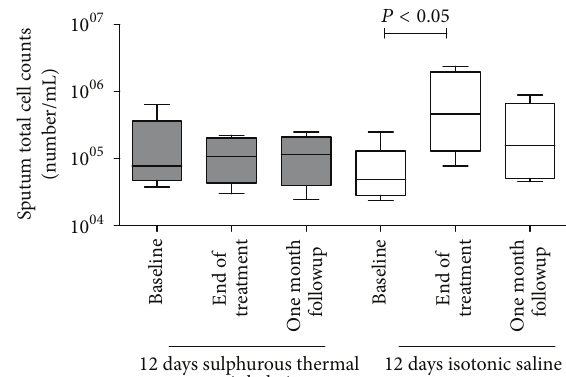
Figure 2: Total sputum cell counts in COPD patients at the baseline, at the end of the inhalation treatment, and one month after the end of the